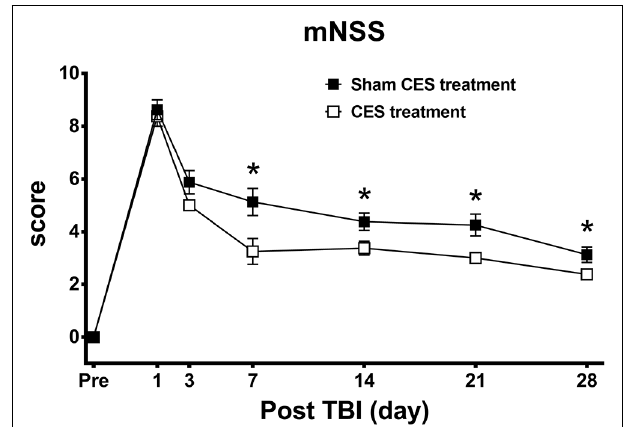
FIGURE 3 | Effect of CES treatment on neurological function evaluated by mNSS. Values are expressed as the mean ± SEM. * p < 0.05, significant difference between the two